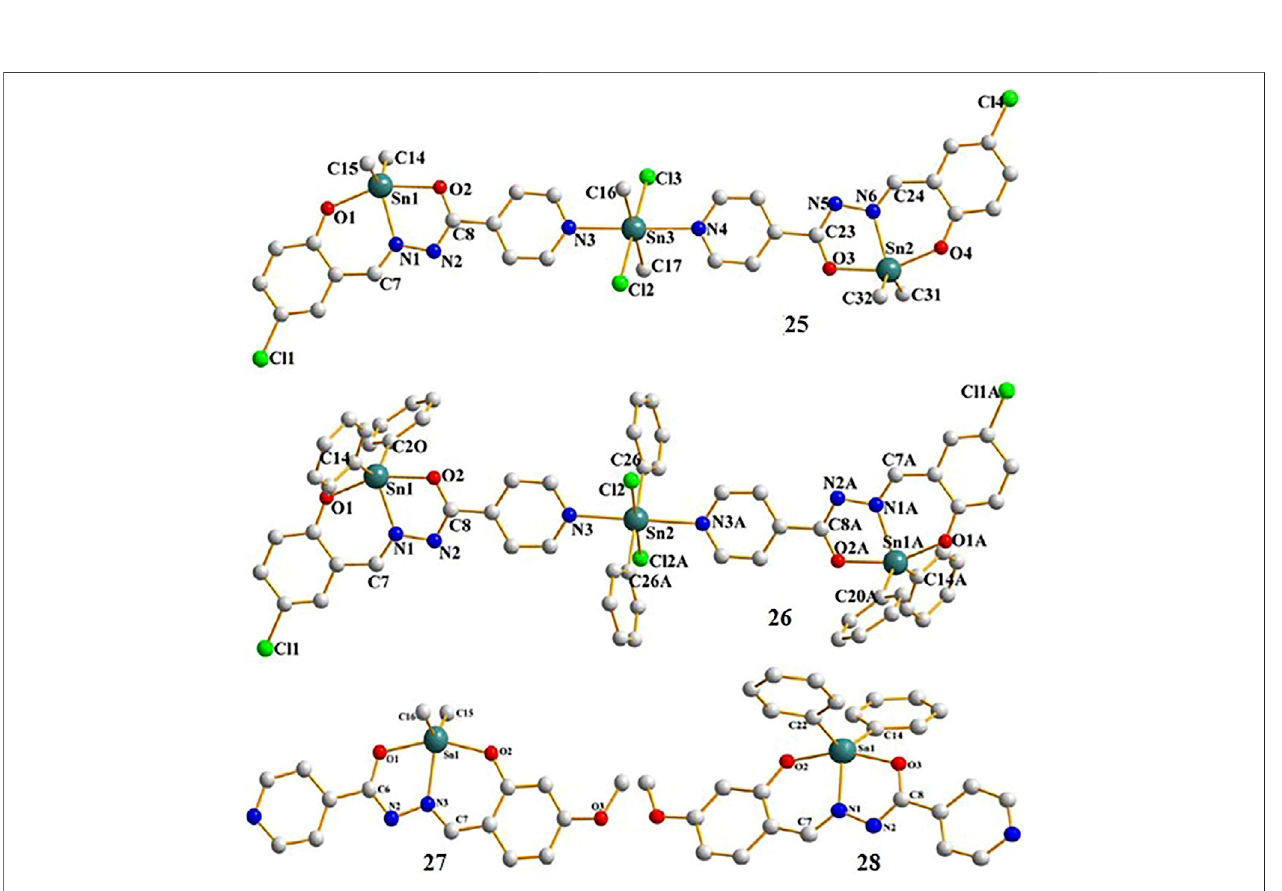
SCHEME 2 | Chemical structure of 29 – 30